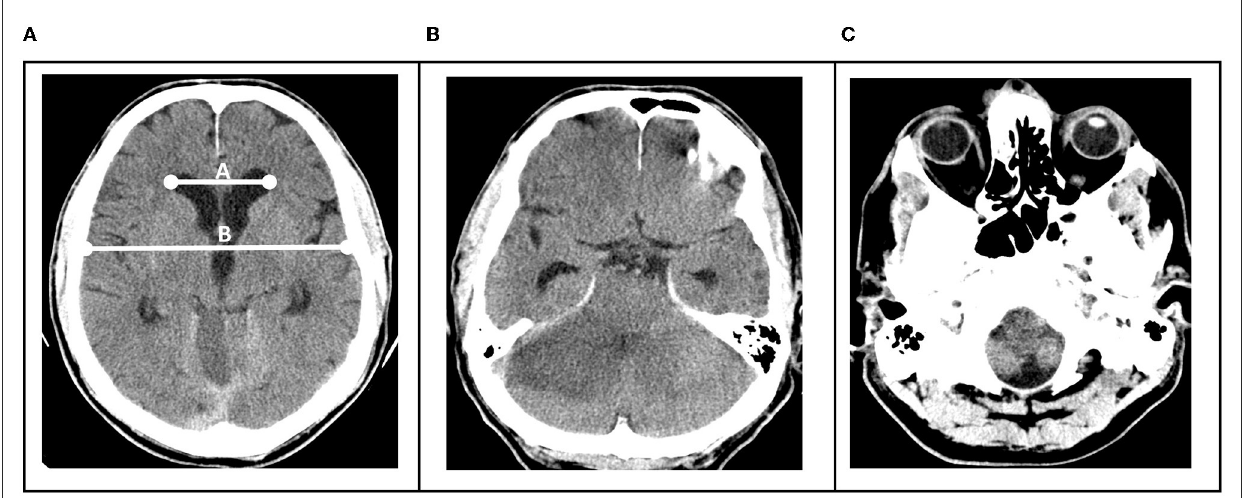
FIGURE1 (A) Hydrocephalus was defined as an Evans Index of > 0.3, determined by division of the distance between frontal horns of the lateral ventricles and the maximal internal diameter of the skull (B) . (B) Brainstem compression was present when uni- or bilateral occlusion of the ambient cisterns was visible. (C) Tonsillar herniation when tonsils were uni- or bilaterally visible below the level of the foramen